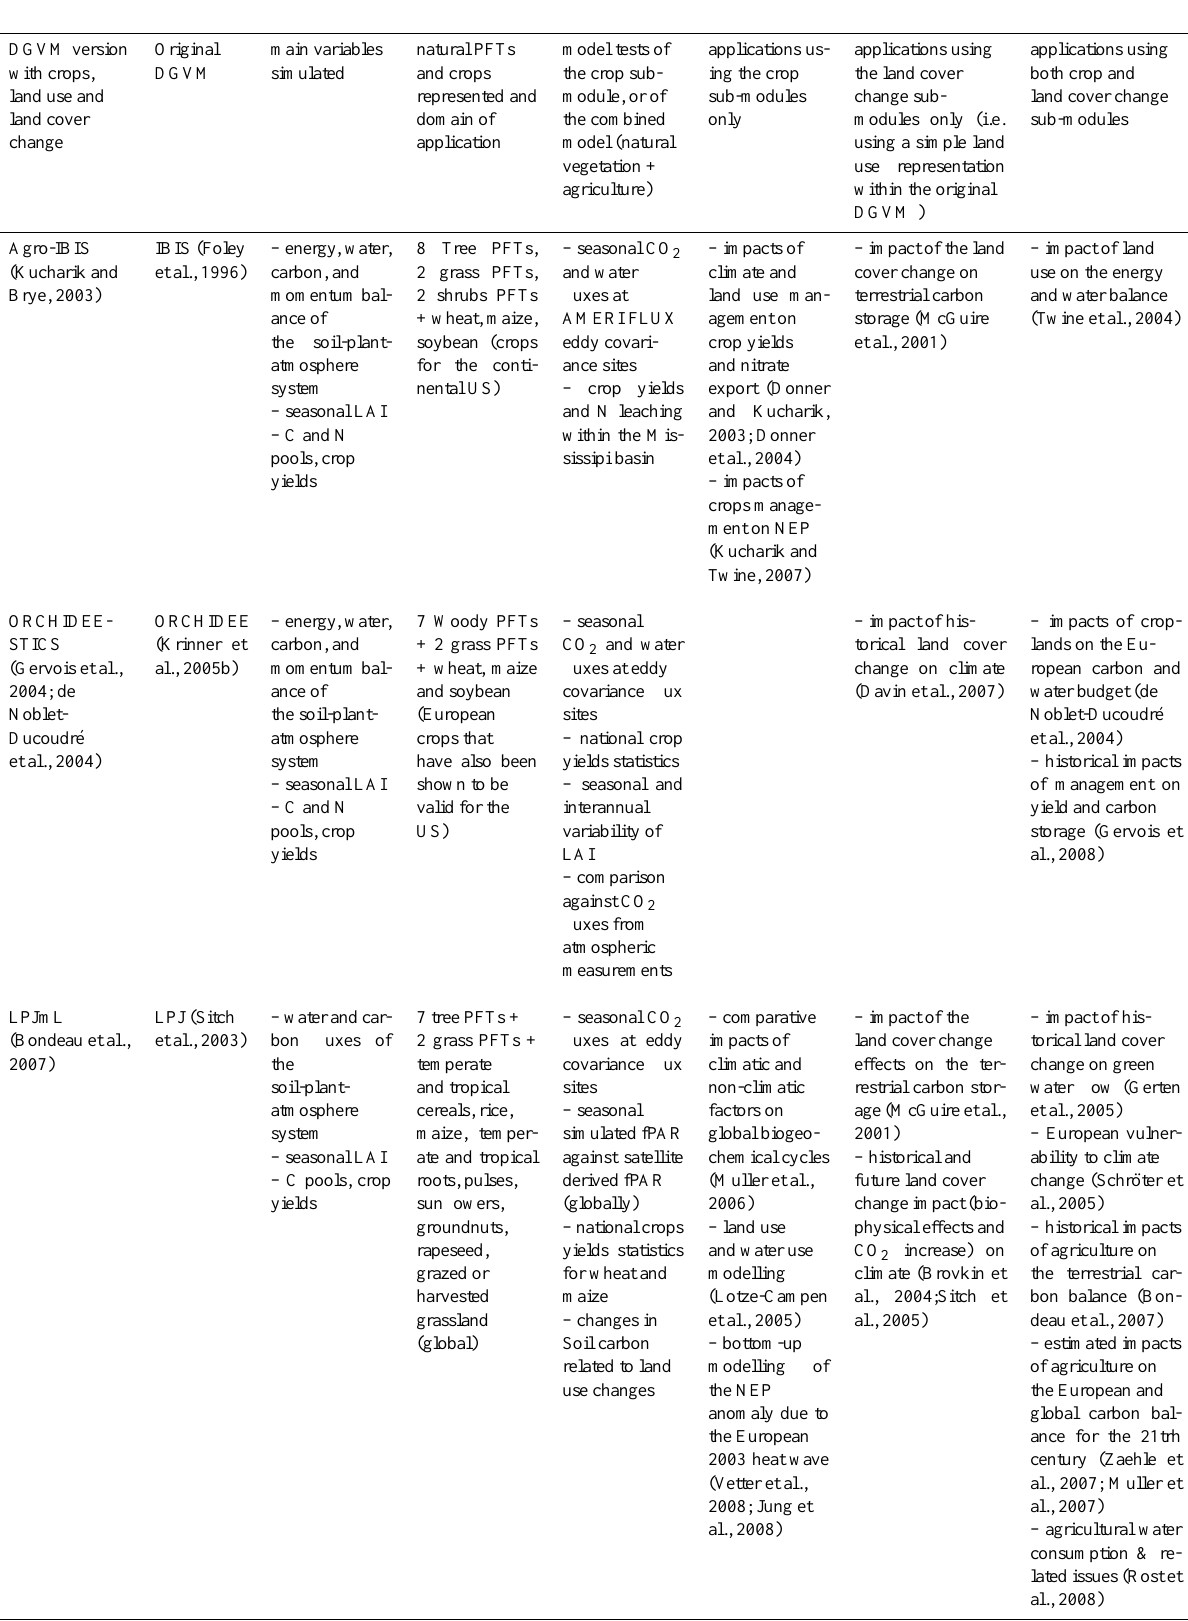
Table 1. Summary overview of three Agro-DGVMs. DGVM version with